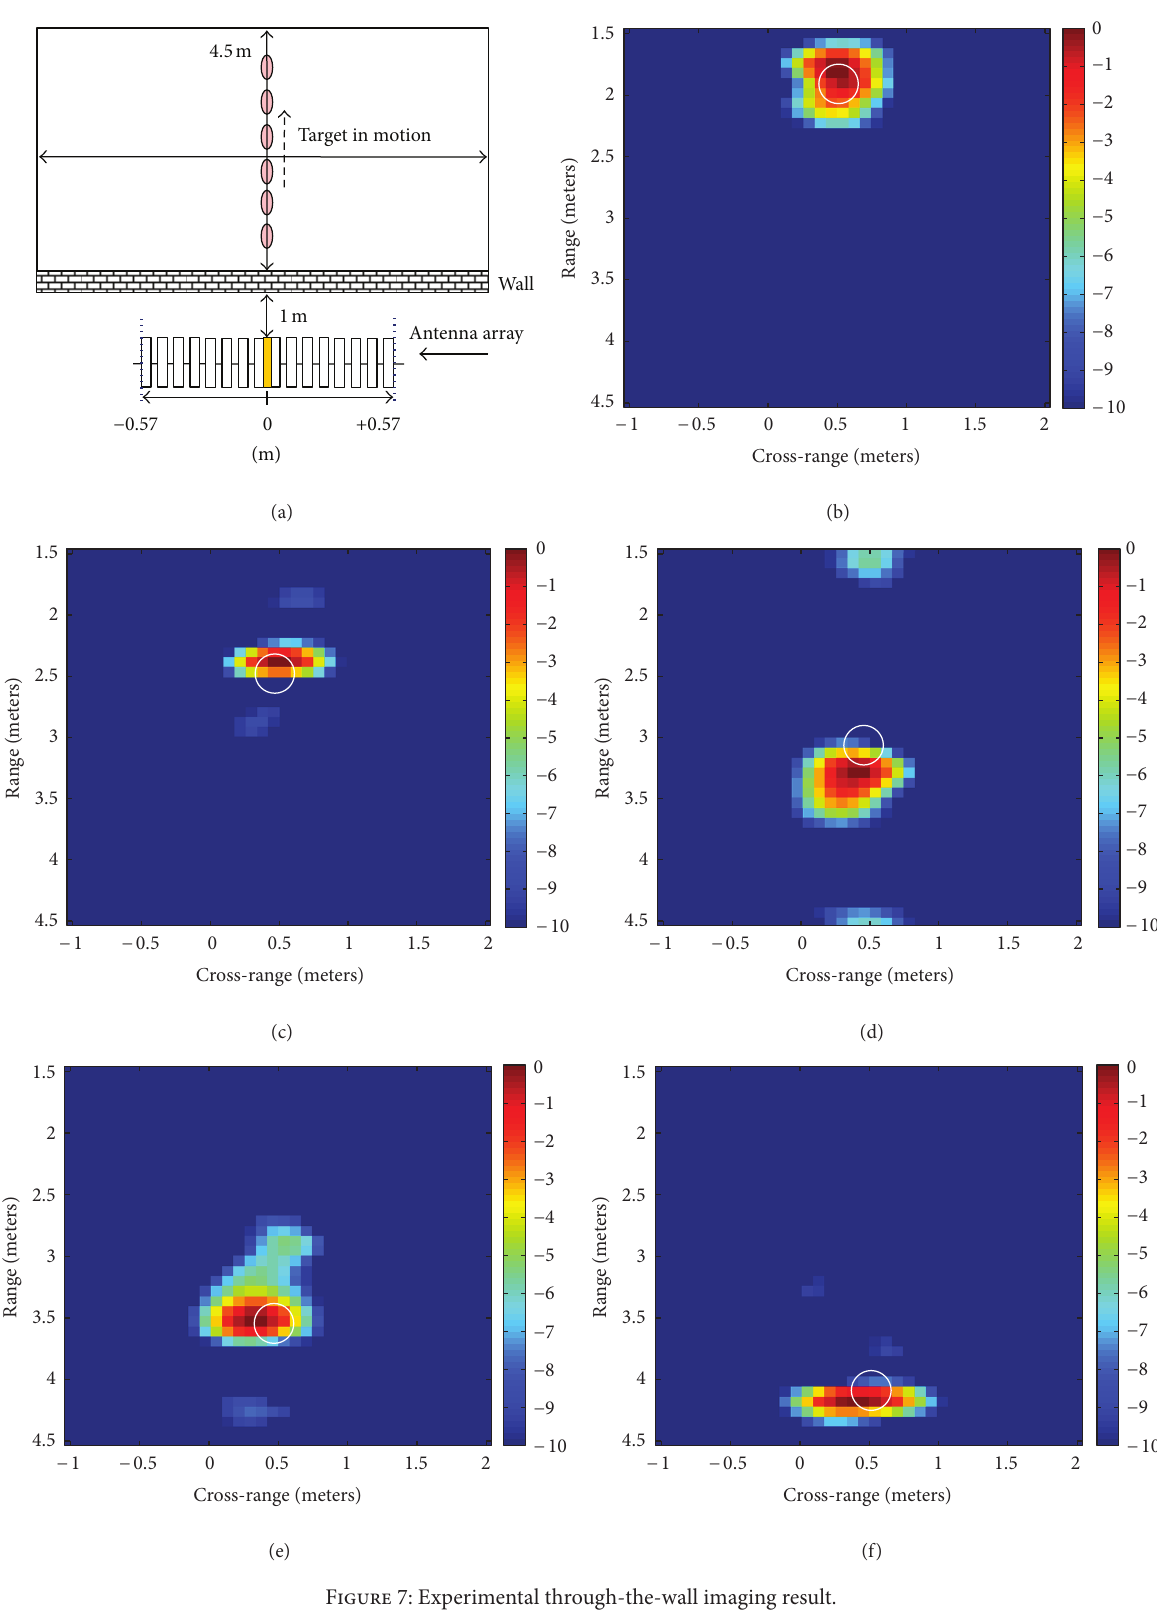
F 7: Experimental through-the-wall imaging